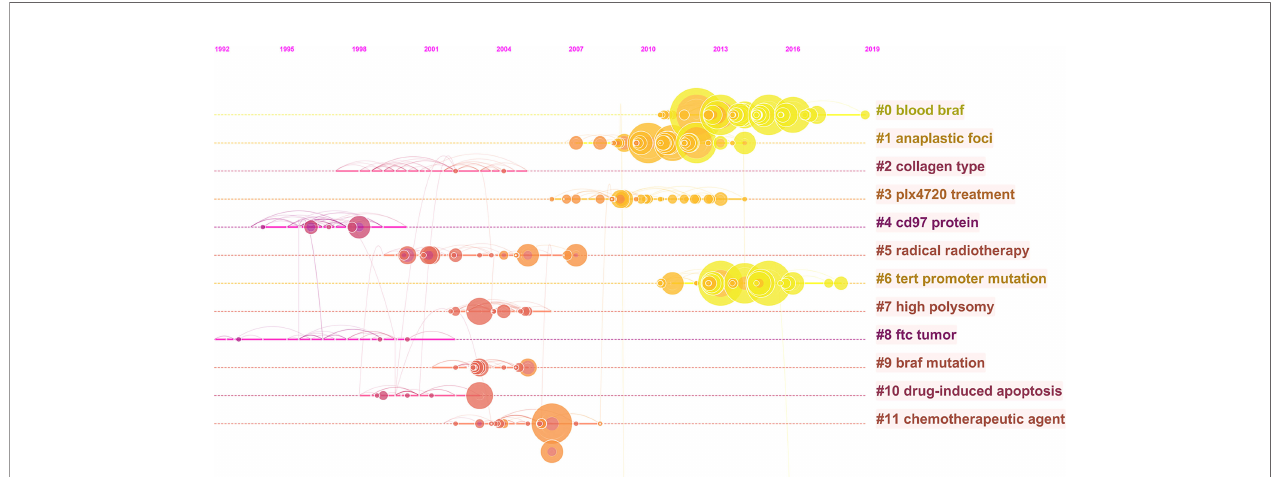
FIGURE 6 | The co-citation timeline map of references in ATC fi eld from 1997 to 2020. Co-cited references that are repeatedly cited in ATC literature were clustered and identi fi ed by CiteSpace. Nodes on the map represented referenced documents. The trend of co-coted literature subjects re fl ected the shift of research concerns. The years were arranged horizontally at the top, and the label of each cluster was displayed at the end of the cluster ’ s timeline.